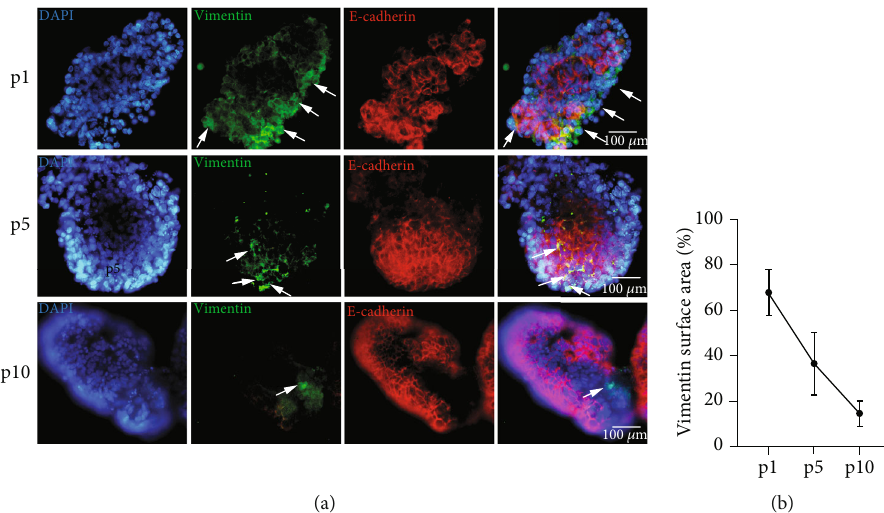
Figure 2: Mesenchymal evolution along HIO passaging. HIOs stained for the epithelial marker, E-cadherin, and the mesenchymal marker, vimentin, in three di ff erent passages (a). Vimentin-positive staining area is shown to be reduced through subsequent passages, suggesting that the mesenchymal component is gradually decreased (b). Representative 40x immuno fl uorescence snapshots are